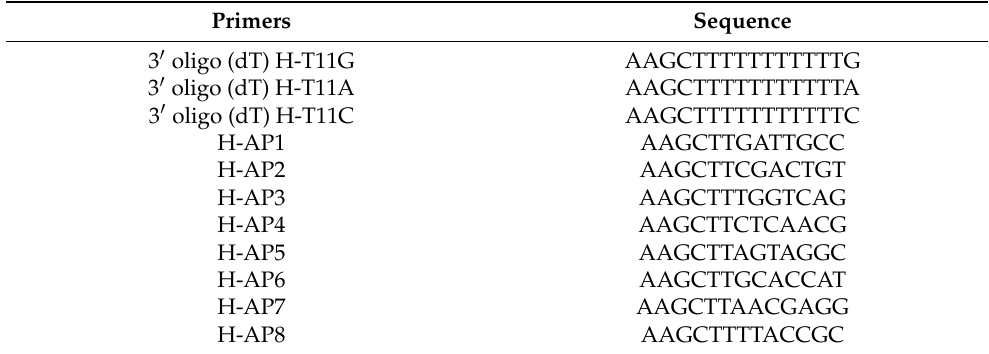
Table 2. Sequences of the 3 oligo (dT) primers and 5 arbitrary primers (H-AP) used in differential display. Primers Sequence 3 (cid:48) oligo (dT)